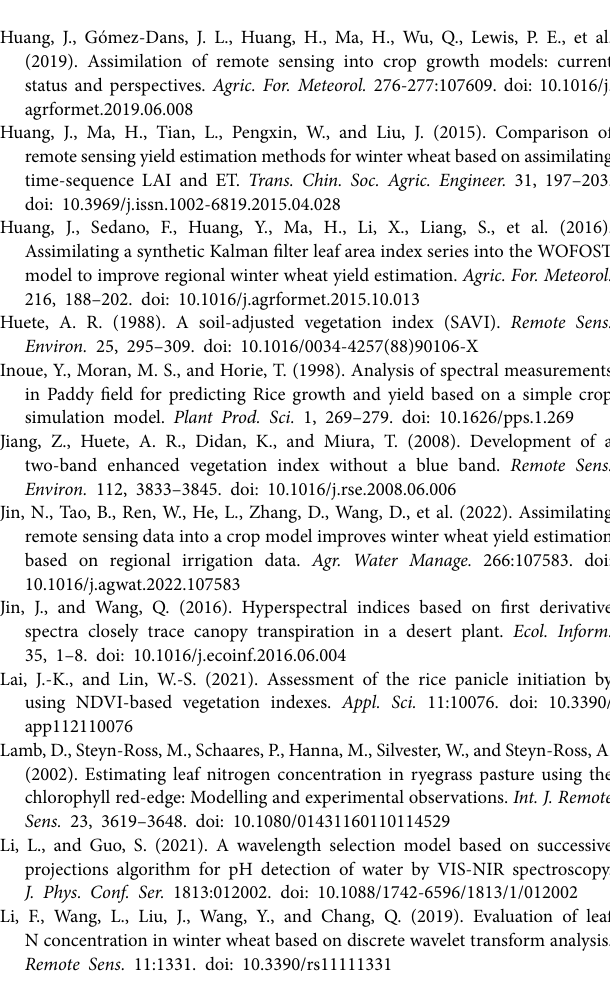
Supplementary Figure 1 | Comparison of the number of sensitive bands after wavelet transform at different scales in various growth stages: (A) elongation stage, (B) heading stage, (C) flowering stage, (D) milky stage. Supplementary Figure 2 | Test results of four growth stages combination model based on first derivative transform: (A) MSR model, (B) RF model. Supplementary Figure 3 | Test results of four growth stages combination model based on first derivative-wavelet transform: (A) MSR model, (B) RF model. Supplementary Figure 4 | Model test results based on the validation set 2: (A) MSR model, (B) RF